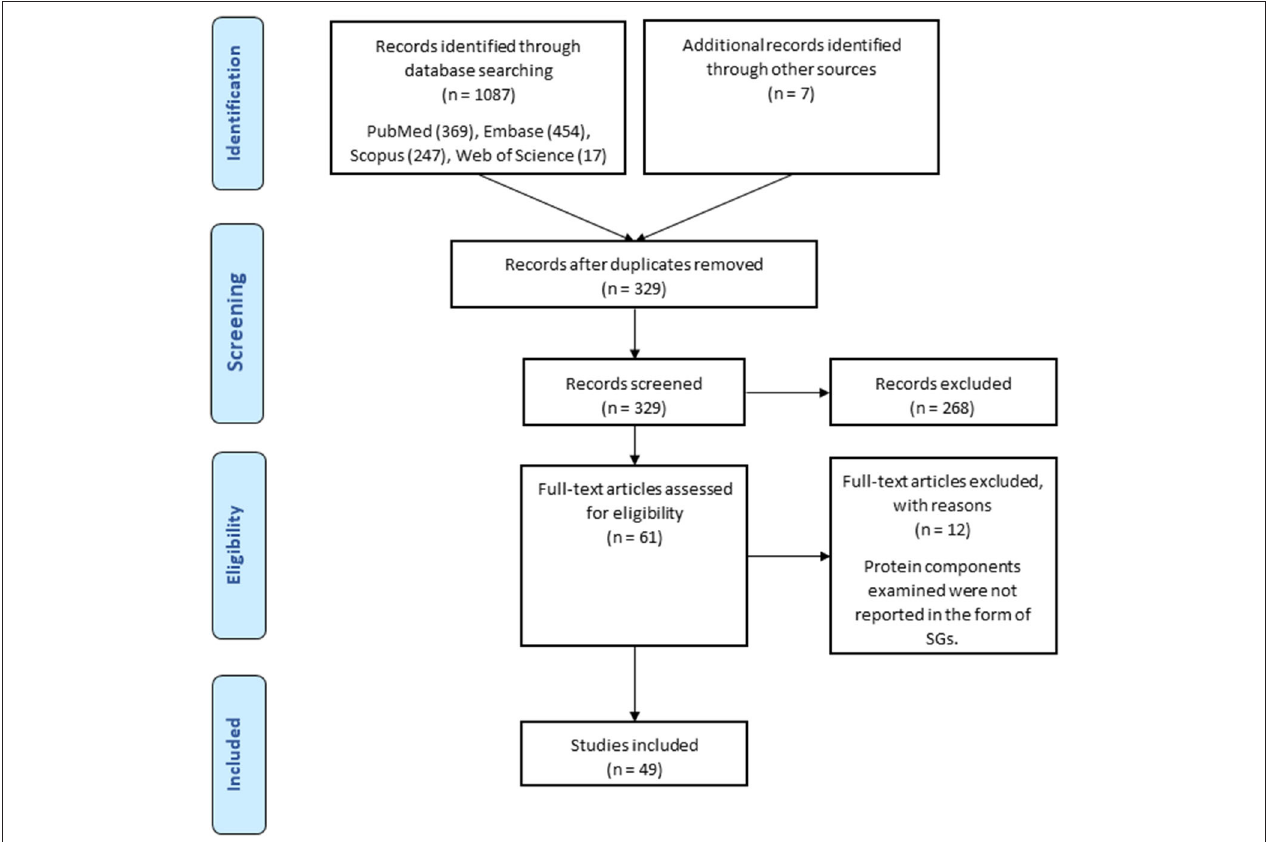
FIGURE 1 | Search strategy flow chart based on the PRISMA flow diagram.